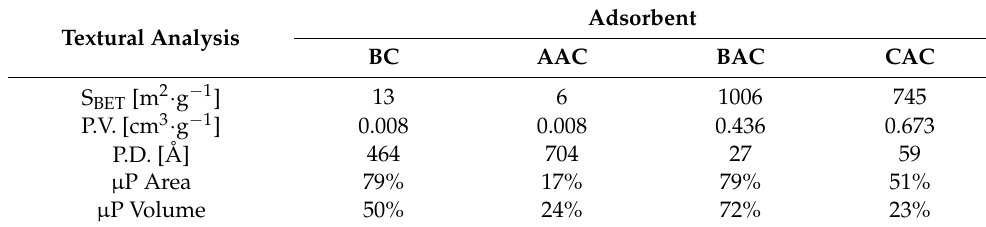
Table 3. Results of the textural analysis of the four materials.